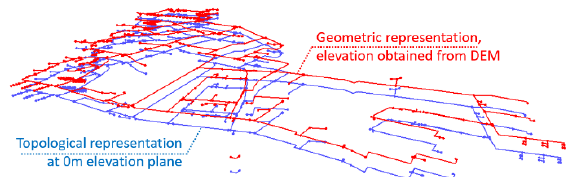
Figure 5. Geometric (red) and topological (blue) representations of the gas low pressure network at different